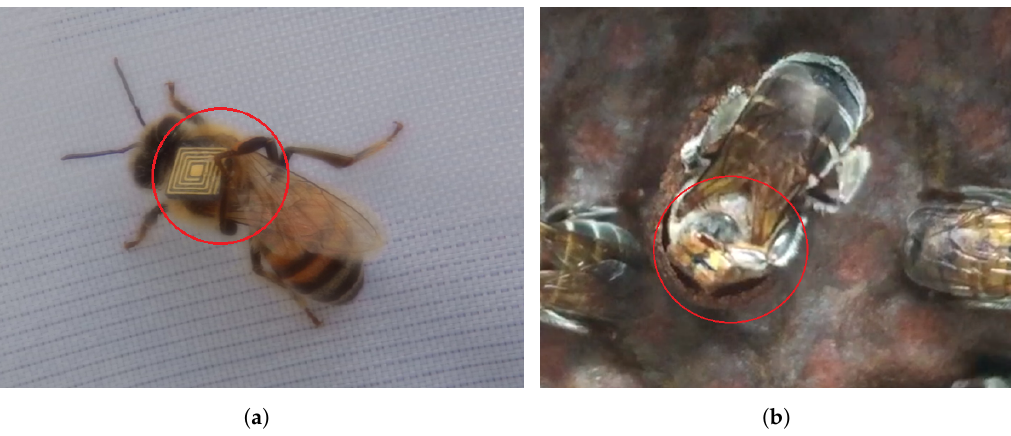
Figure 4. Example of bees disturbed by the RFID tags. ( a ) Apis mellifera trying to remove the RFID tag; ( b ) Melipona melanoventer trying to remove the RFID